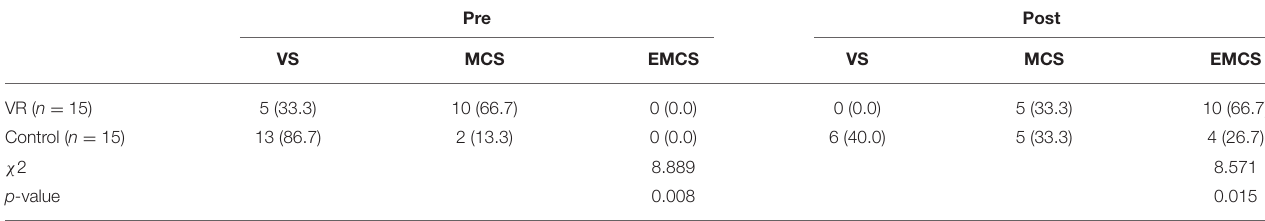
TABLE 3 | The classification of consciousness levels in two groups before and after treatment (n; %).